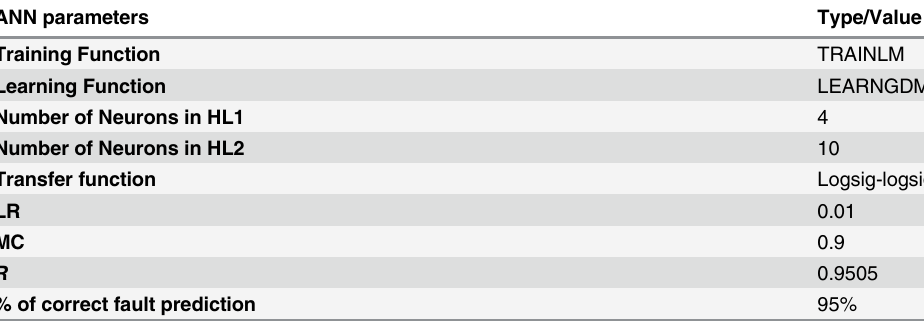
Table 4. The properties of selected ANN after tuning LR and MC.